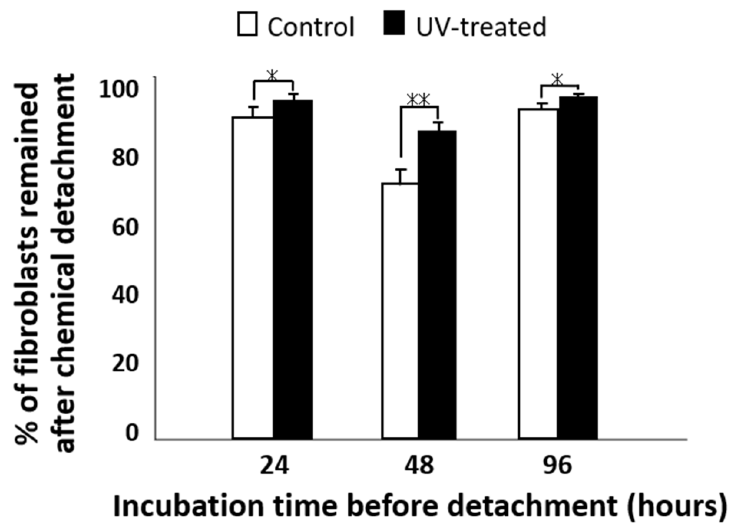
Figure 6. Percentage of attached fibroblasts remaining after chemical detachment; cells were cul- tured for 24, 48, and 96 h on titanium disks with and without UV treatment. Data are mean ± SD ( n = 6). ** p < 0.01, * p < 0.05, statistically significant difference between the control and UV-treated surfaces.